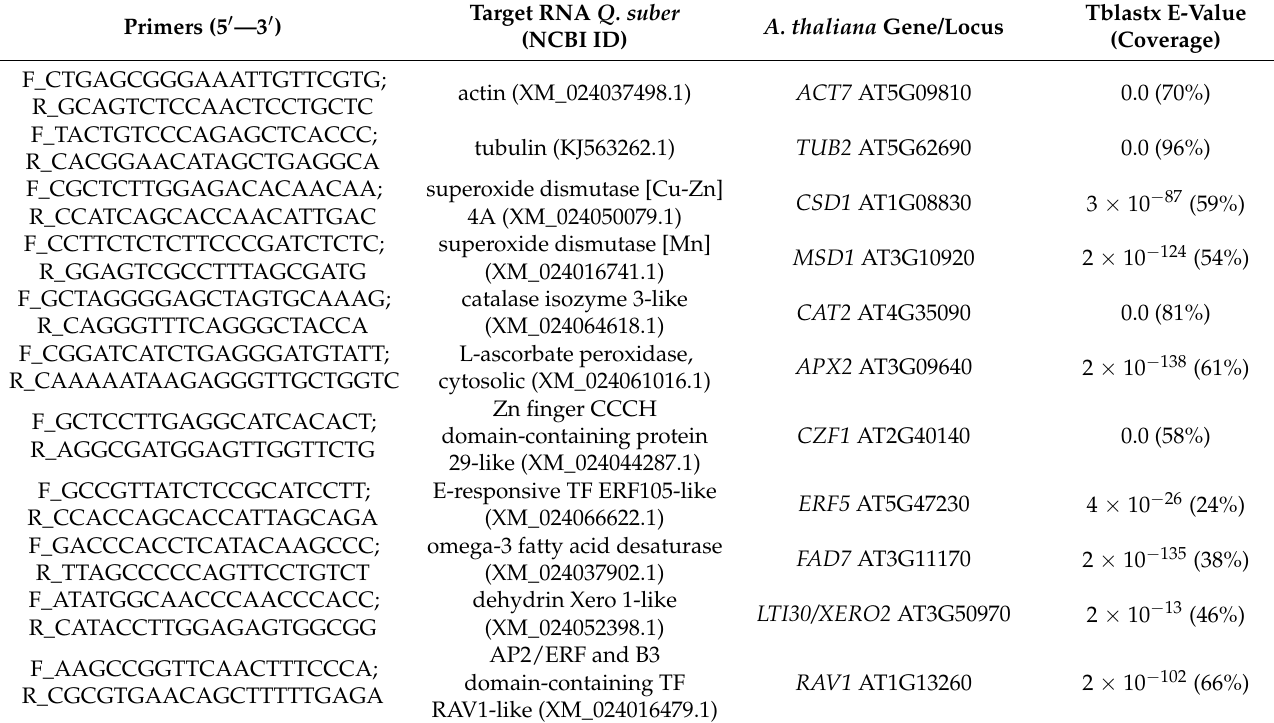
Table 1. Primers used for